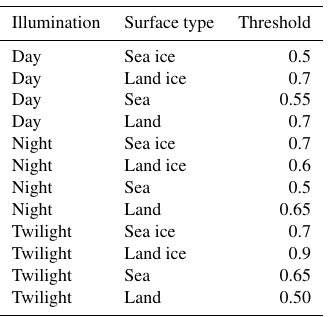
Table B4. Empirical thresholds used to convert the output of the cloud phase ANNs into a binary cloud phase. Thresholds depend on illumination conditions and surface